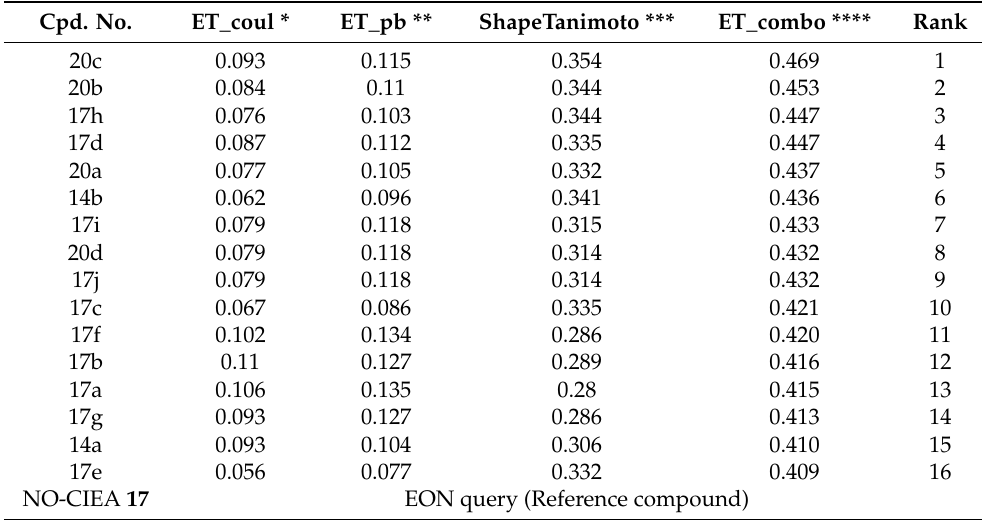
Table 4. EON results of shape and electrostatic similarity between the designed compounds and the query NO-CIEA 17